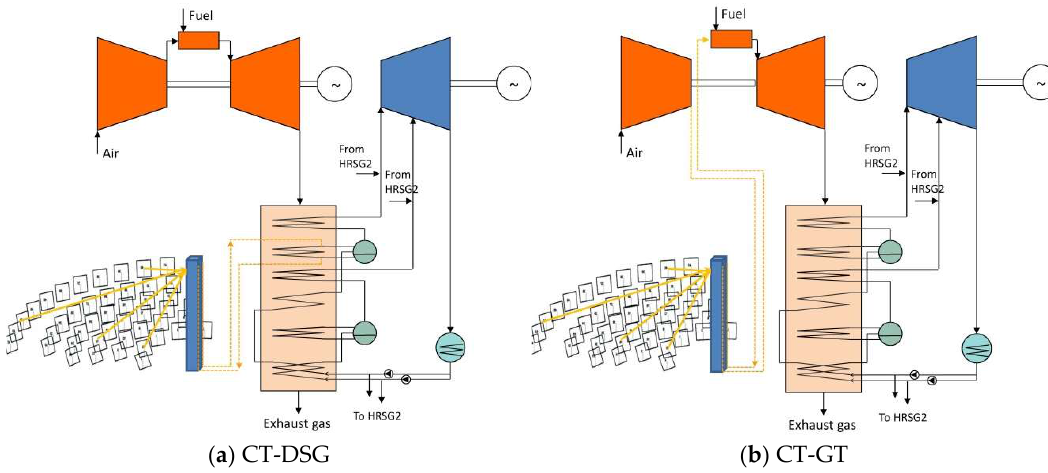
Figure 3. Layout of the configuration based on CT.